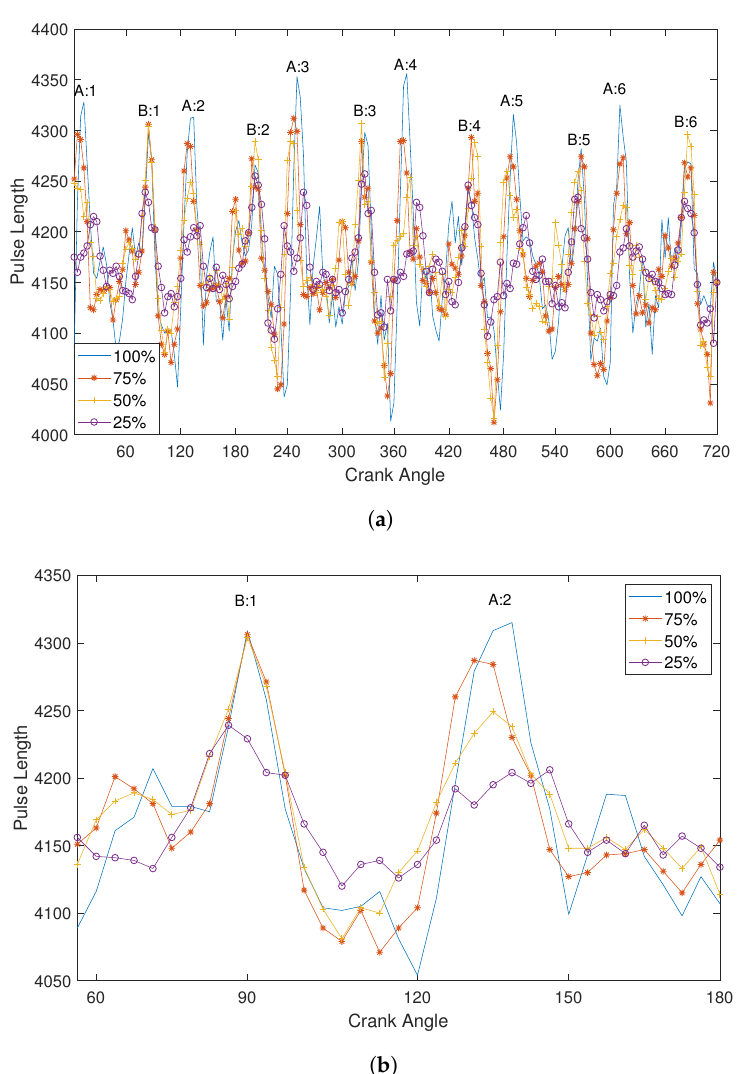
Figure 7. CAD signals of different engine loads: ( a ) full CAD signal represents the combustion strokes of 12 cylinders, and ( b ) part of the CAD signal represents combustion strokes of two